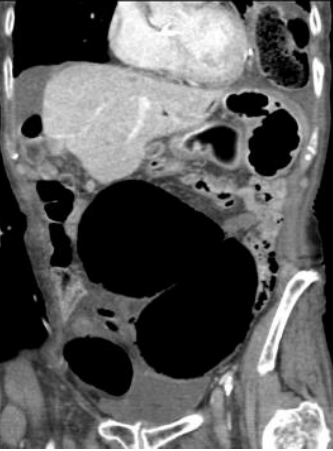
Figure 4. CT axial image demonstrating a grossly distended caecum with diameter > 10 cm.